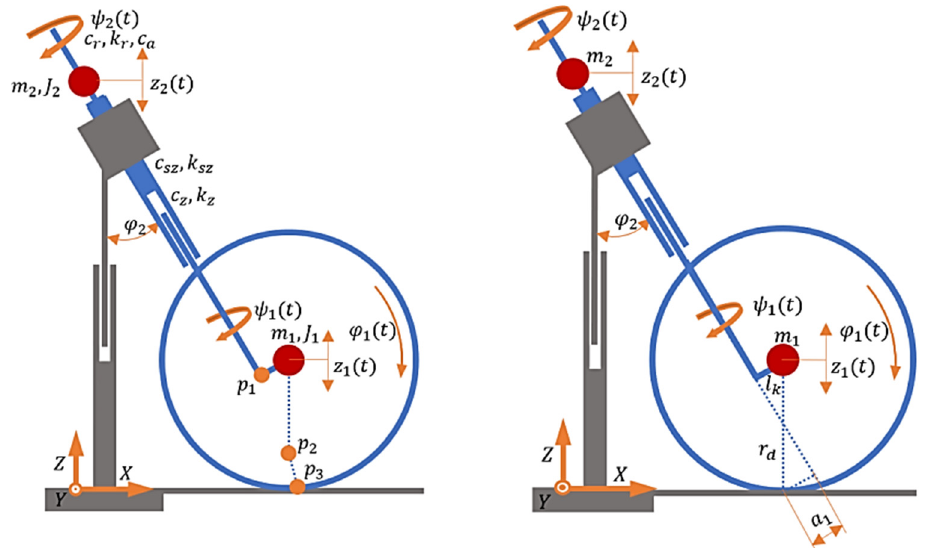
Figure 2. Physical model of a motorcycle steering system.